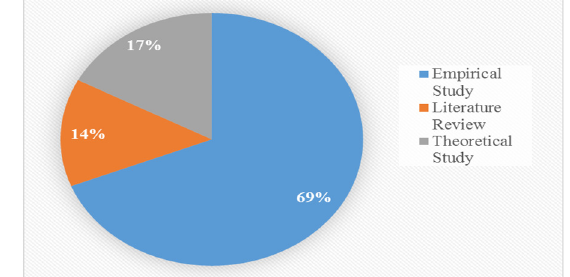
FIG. 4. METHODS USED IN THE ACCEPTED STUDIES